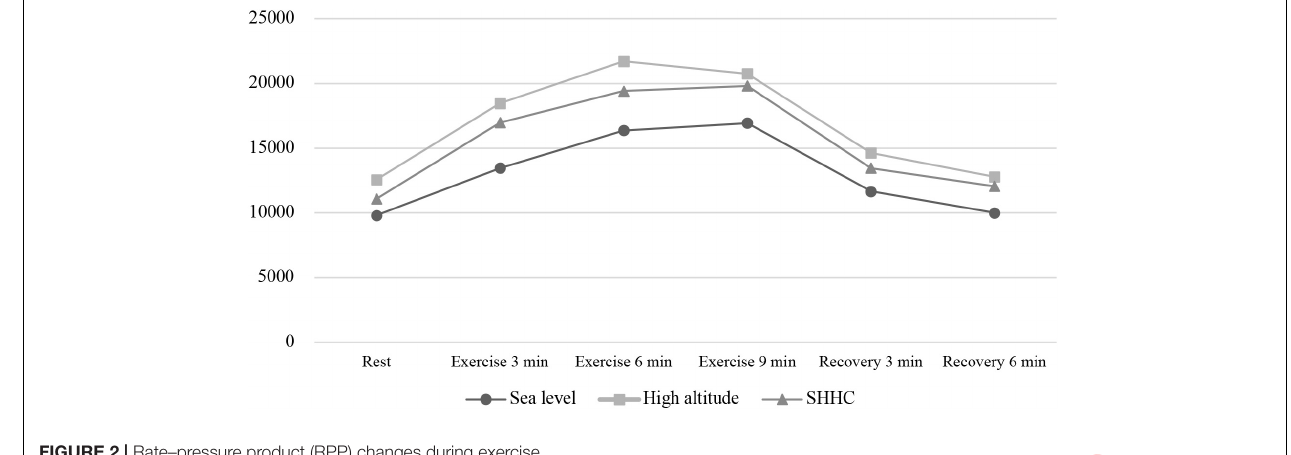
FIGURE 2 | Rate–pressure product (RPP) changes during exercise.